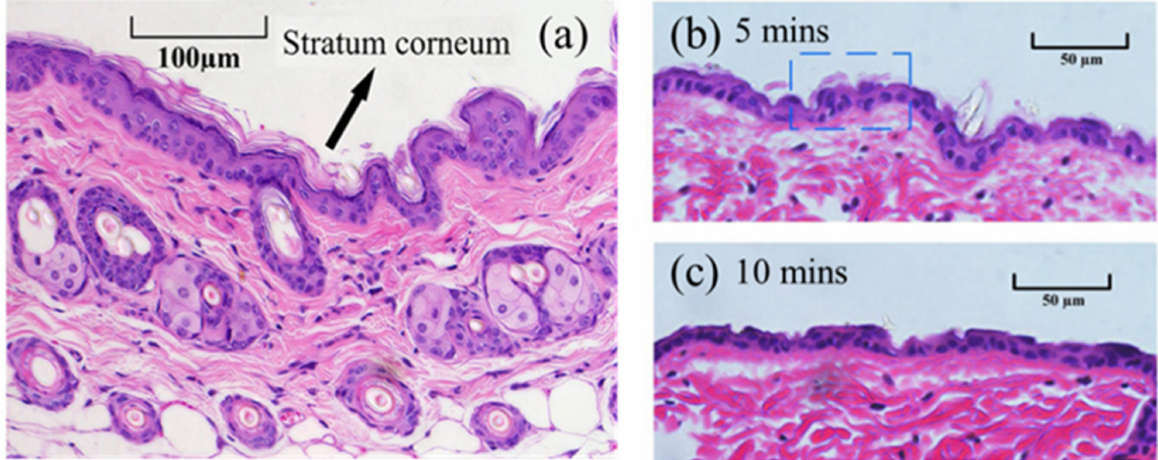
Figure 6. The HE (hematoxylin-eosin) staining of the mice skin before/after LTP treatment: ( a ) The HE staining of normal mice skin before plasma treatment. ( b ) The HE staining of nor- mal skin after 5 min plasma treatment. The SC is damaged after Plasma treatment for 5 min. ( c ) SC is totally removed by the 10 min plasma treatment. Unlike the plasma scanning treatment for IMQ-induced psoriasis, the position of LTP treatment was fixed during SC damage